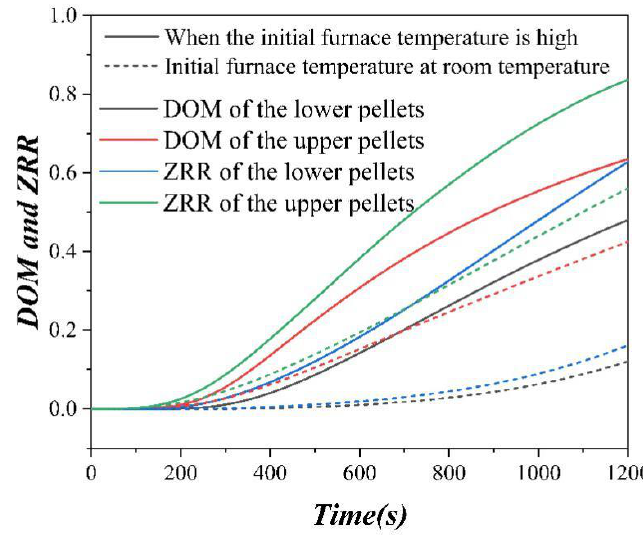
Figure 12. Variation of DOM and ZRR in the multilayer ellipsoid spherical bed with Figure 12 . Variation of DOM and ZRR in the multilayer ellipsoid spherical bed with time.